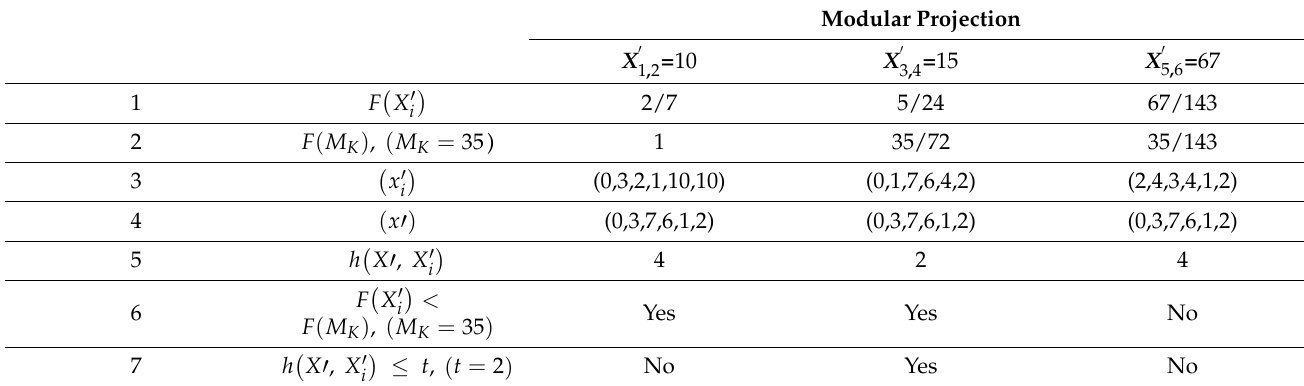
Table A3. Computed modular projections and their